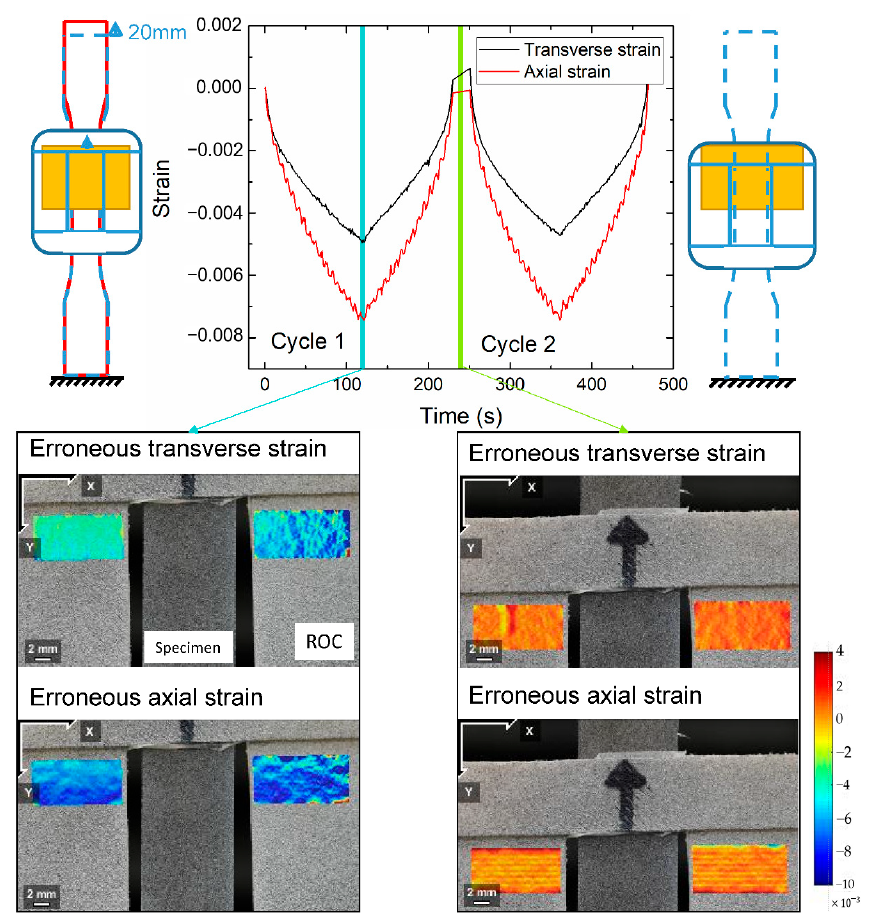
Figure 2. Erroneous Green strains measured on the ROC due to the out-of-plane motion over two loading–unloading cycles. The erroneous strains increase with the stretch, and return to zero when the specimen is unloaded. This phenomenon is evident from the DIC measurement on the undeformed ROC. The left and right panels were taken at stretch ratios of 1.186 and 1.0188, respectively.